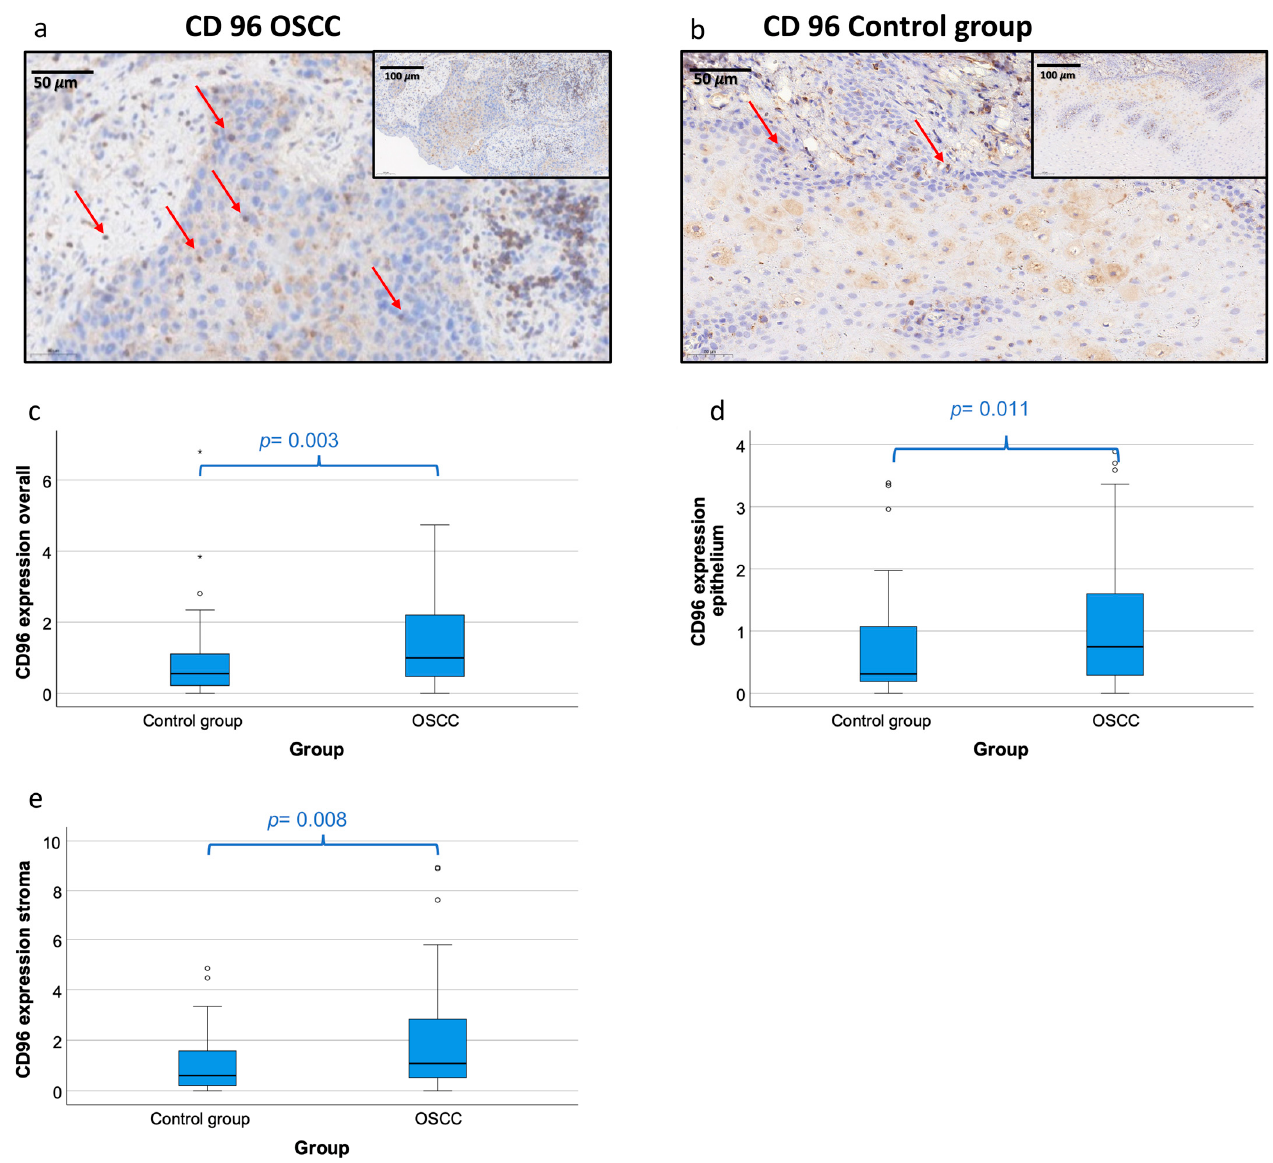
Figure 1. CD96 protein expression in OSCC tumor tissue and healthy control mucosa. ( a , b ) Representative micrographs showing the typical expression pattern of CD96 in OSCC tissue ( a ) and healthy control mucosa ( b ). All micrographs are given in high-power magnification (30 × magnification) and panoramic magnification (15 × magnification). CD96 staining shows a cytoplasmatic expression pattern with accentuation of the plasma membrane. CD96 expressing cells are indicated with arrows. ( c – e ) Box plots of the median CD96 protein expression rates in tumor tissue of OSCC patients (OSCC) and oral mucosa of healthy volunteers (control group). The median labelling indices (positive cells vs. all cells) of CD96-expressing cells in the complete analyzed tissue (CD96 expression overall, ( c )), the epithelial tumor and mucosa compartment (CD96 expression epithelium, ( d )), and in the stroma tissue (CD96 expression stroma, ( e )) provided by immunohistochemistry are given. Higher labelling indices indicate higher CD96 protein expression. The median, the interquartile range, and the standard deviation are provided. Statistical analyses were carried out using